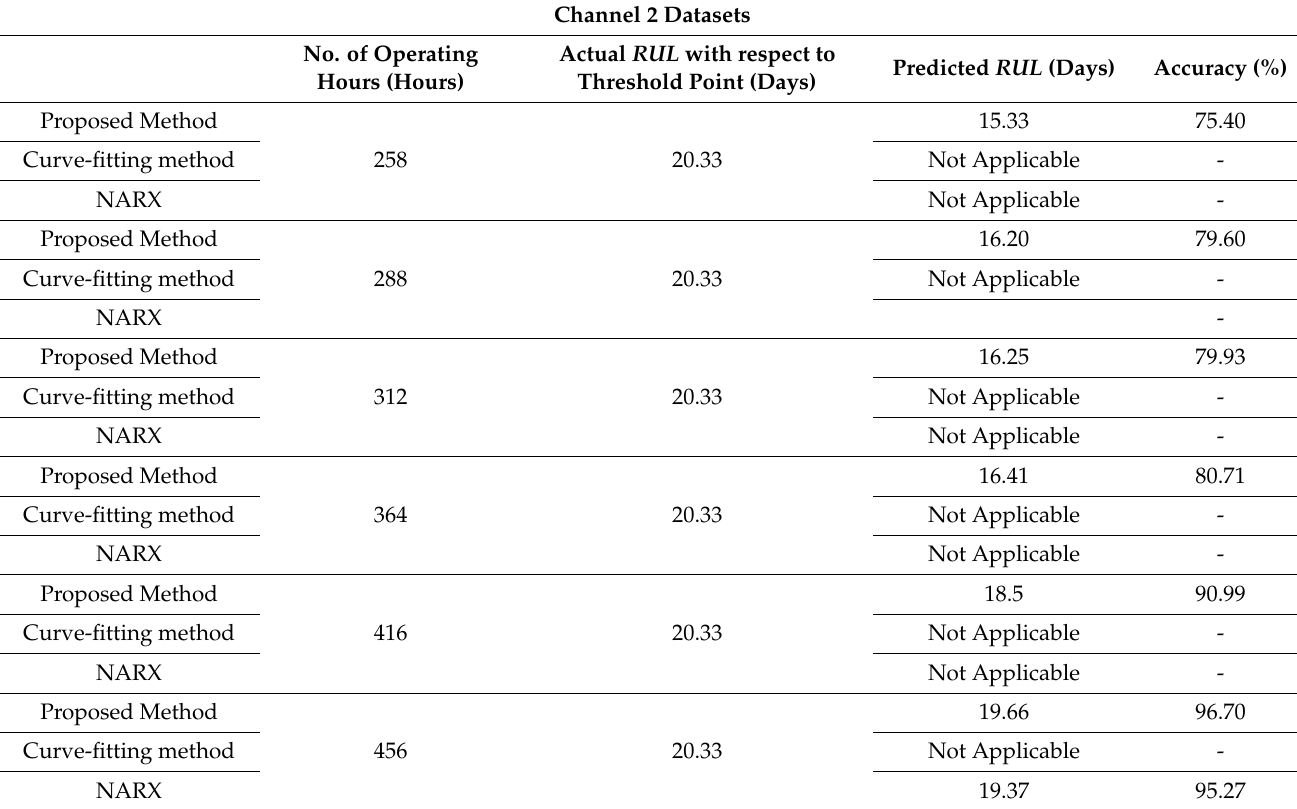
Table 3. RUL predicted by developed and other existing models for channel